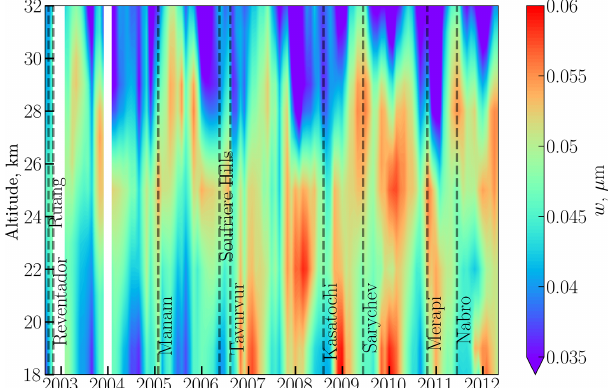
Figure 12. Deseasonalized time series (anomalies) of w as defined by Eq. (2) retrieved from SCIAMACHY limb data in the tropics (20 ◦ N–20 ◦